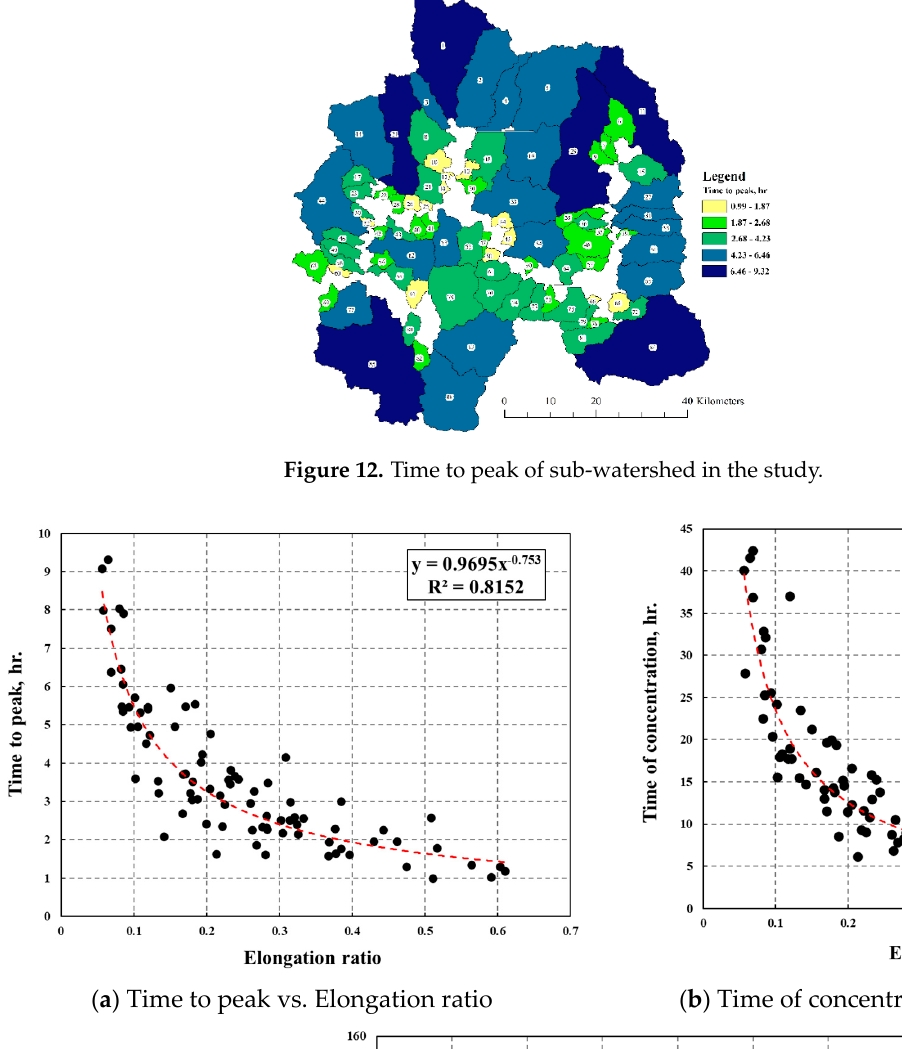
15 of 21 Figure 10. Time of concentration of sub-watershed in the study.